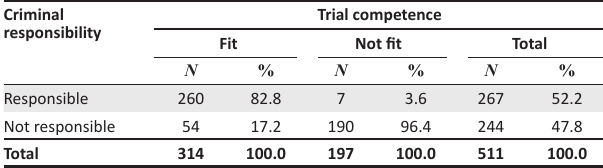
TABLE 6: Trial competence and criminal responsibility ( n =